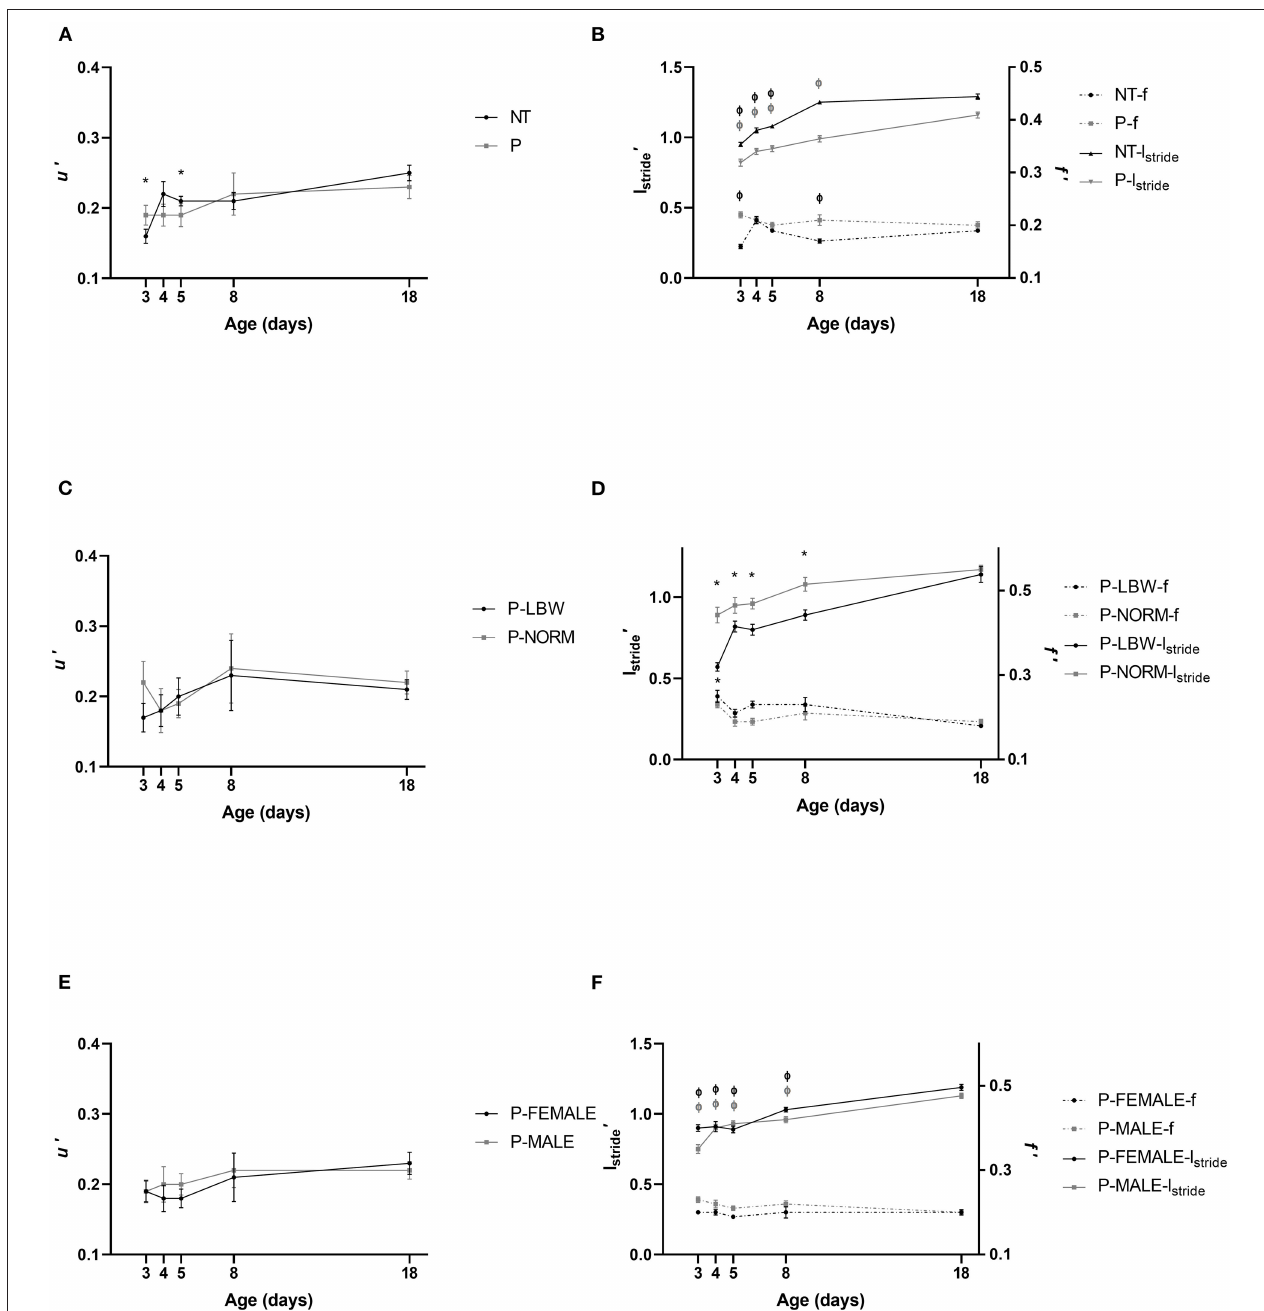
FIGURE 2 | Neuromotor control. All values are mean SE. (A) Normalized speed ( u ′ ) according to condition (P: preterm, gray; T: term, black) and age. u ′ of P and T ± piglets is similar. Mean values indicated with * differ from d18. (B) For normalized stride length ( l ′ stride , full line) and stride frequency ( f ′ , dotted line), an interaction was observed between condition (P vs. T) and postnatal age. l stride ′ was shorter in P piglets. At d3, d5, and d8, f ′ was higher in P piglets, compared to T piglets. Mean values of l stride ′ and f ′ indicated with “ Φ ” were different from d18. (C) Normalized speed ( u ′ ) of preterm pigs did not differ with birth weight (normal birth weight (P-NORM); low birth weight (P-LBW) and postnatal age. (D) Normalized stride length ( l ′ stride , full line) and normalized stride frequency ( f ′ , dotted line) according to birth weight (P-NORM vs. P-LBW) and postnatal age. l stride ′ was higher for P-NORM, and f ′ was overall higher for P-LBW. Mean values of l stride ′ and f ′ indicated with “*” were different from d18. (E) Normalized speed ( u ′ ) did not differ according to sex of preterm piglets (female: P-FEMALE; male: P-MALE) and postnatal age. (F) Normalized stride length ( l ′ stride , full line) and normalized stride frequency ( f ′ , dotted line) according to sex (P-MALE vs. P-FEMALE) and postnatal age. There was an interaction of postnatal age and sex for l ′ stride indicating that l stride was higher for P-FEMALE at d3, 8, and 18, while f ′ was overall higher in P-MALE. Mean values of indicated with “ 8 ” differ significantly from d18 for l ′ stride . Black colors indicate differences in T while gray colors indicate differences in P piglets.